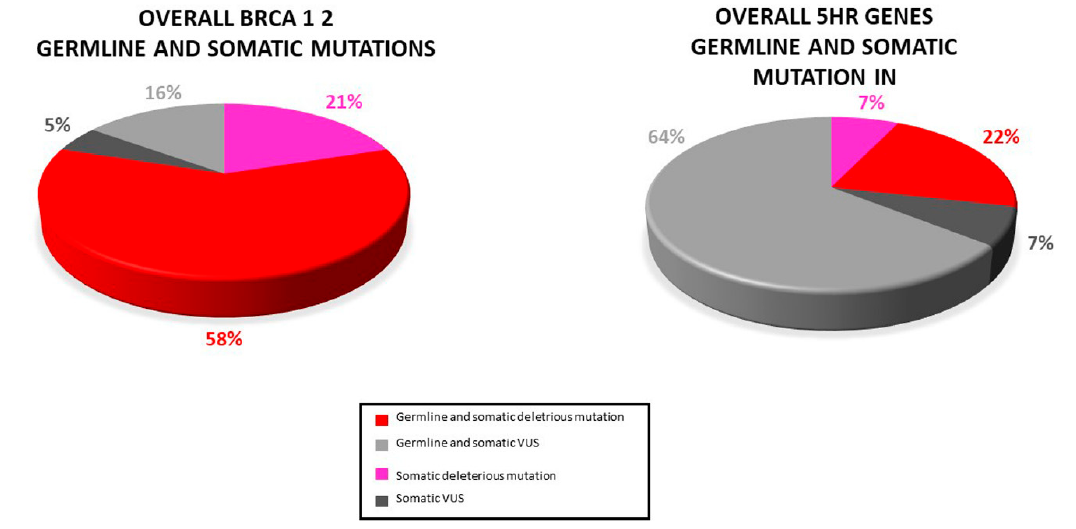
Figure 6. Distribution of somatic and germline variant detected in our study: Most somatic variants (pathogenic and VUS) were also found in the paired blood sample.